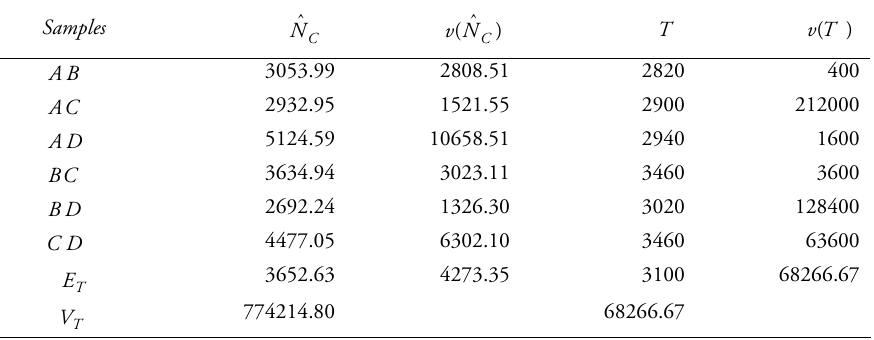
Sampling distributions of T and